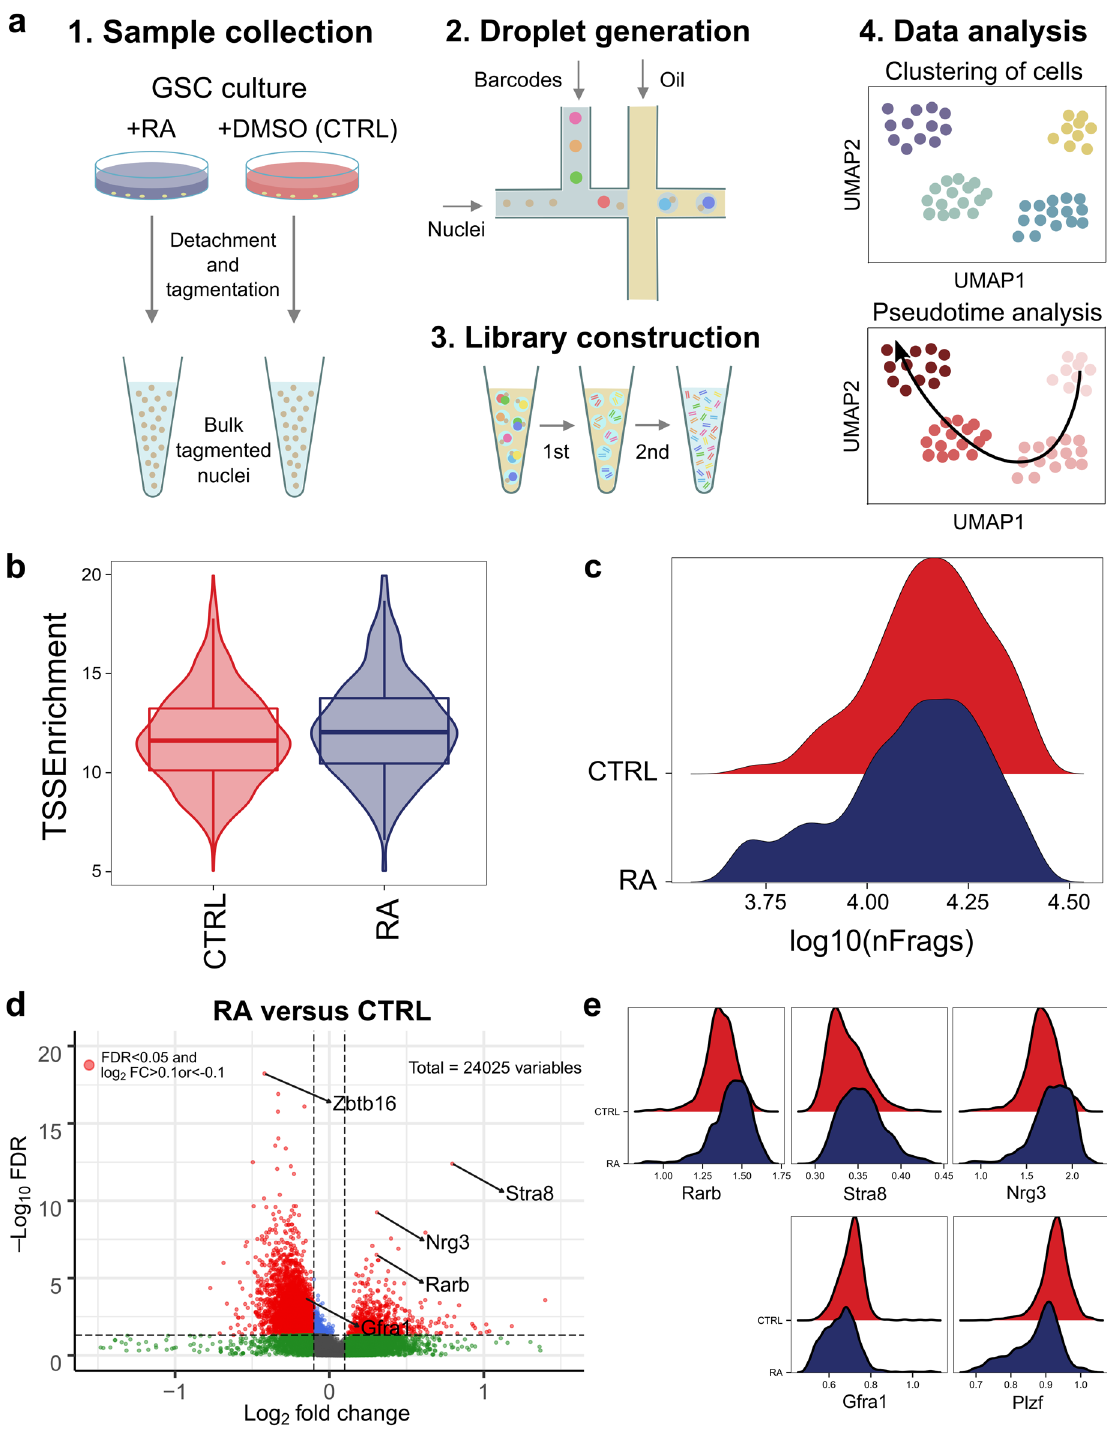
Figure 2. Profiling chromatin accessibility of germline stem cells (GSCs) after retinoic acid (RA) treatment. ( a ) Schematic of experimental design. The workflow of sample collection after RA treatment and scATAC- seq to measure single nuclei accessibility on the BioRad SureCell ATAC-Seq platform. ( b ) Violin plot of TSS enrichment scores. ( c ) Ridge plot of number of unique fragments. ( d ) Pairwise comparison of gene scores between CTRL and RA-treated samples. The volcano plots show the differential gene score against the − log10(P value) of all investigated genes; each dot represents one gene. Red dots indicate the genes with FDR < 0.05 and log2FC > 0.1 or < -0.1. ( e ) Ridge plots of gene activity of SSC self-renewal and differentiation genes in GSCs with (blue) and without (red) RA